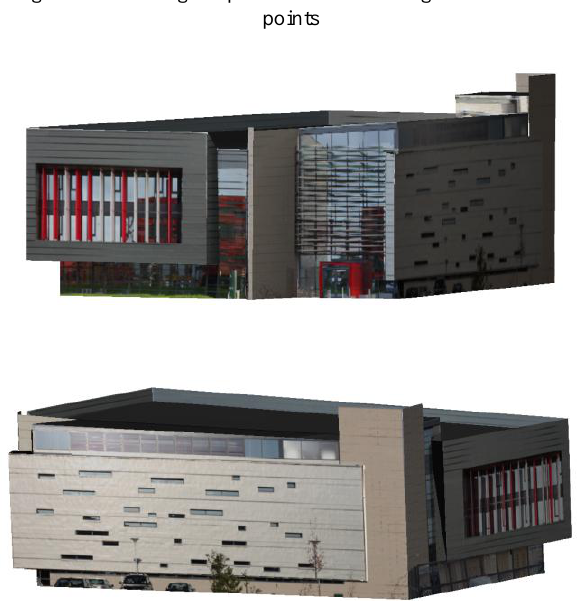
Figure 13. Two perspective views of the 3d building model created from the Canon EOS 5D Mk II